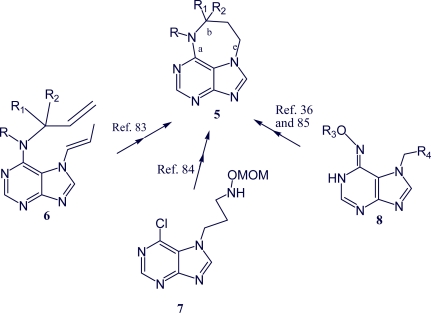
Synthetic routes to asmarines [83].